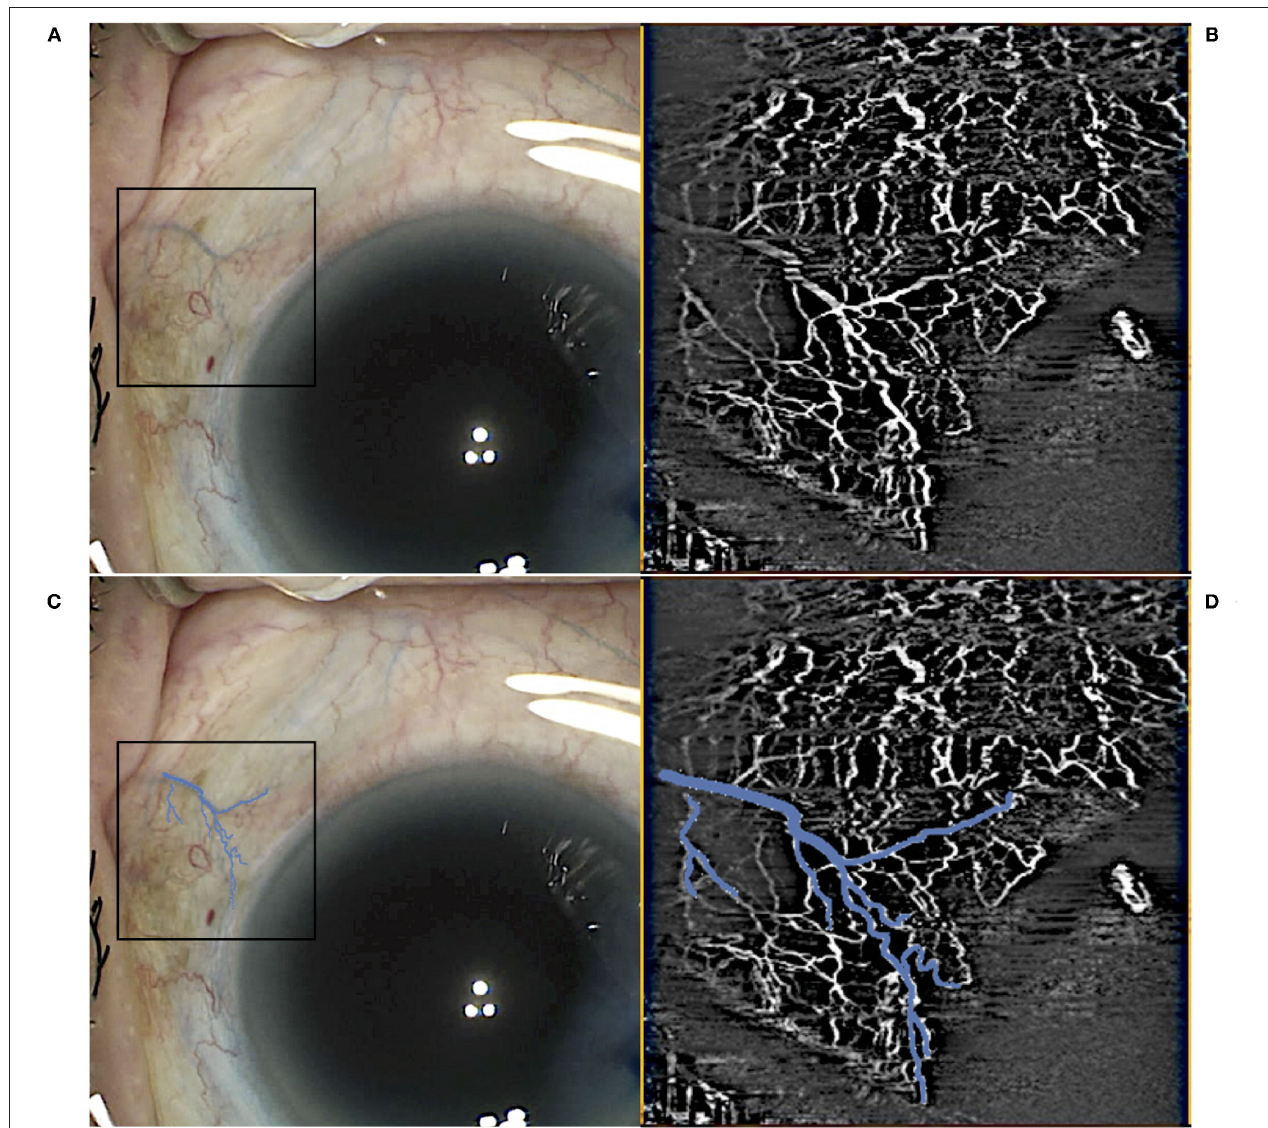
FIGURE 3 | Example of intraoperative identification of episcleral vessels using trypan blue immediately postimplant (A) with the corresponding optical coherence tomography angiography (OCTA) scan in the sector (B) . Trypan blue vessels in the region of interest were highlighted (C) with an overlay on the intraoperative images (D) before vessel density